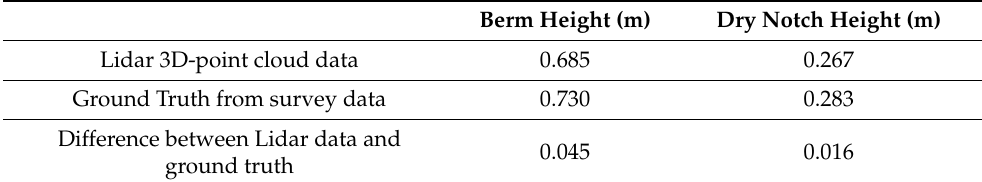
Table 1. Comparison of difference between Lidar 3D-point cloud data and ground truth.